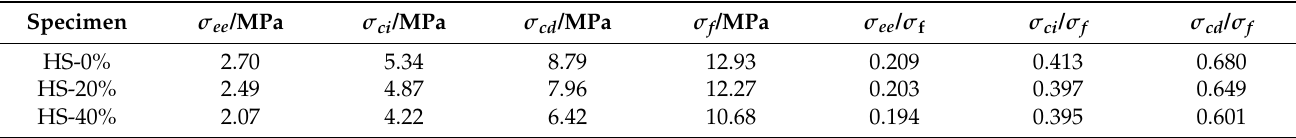
Figure 2. Stress − strain curve of the dry specimen. The characteristic stress threshold values can be obtained from Figures 2 and 3, as shown in Table 1. Table 1. Typical specimen characteristic stress threshold